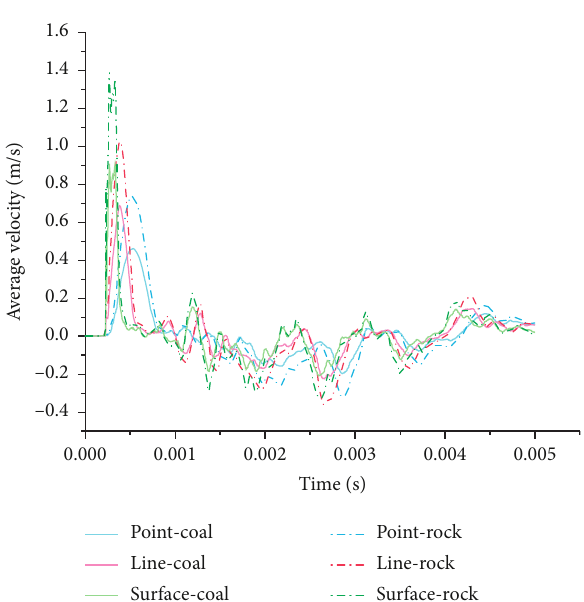
Figure 18: Average velocity of nodes in the tail beam collision contact zone under different contact